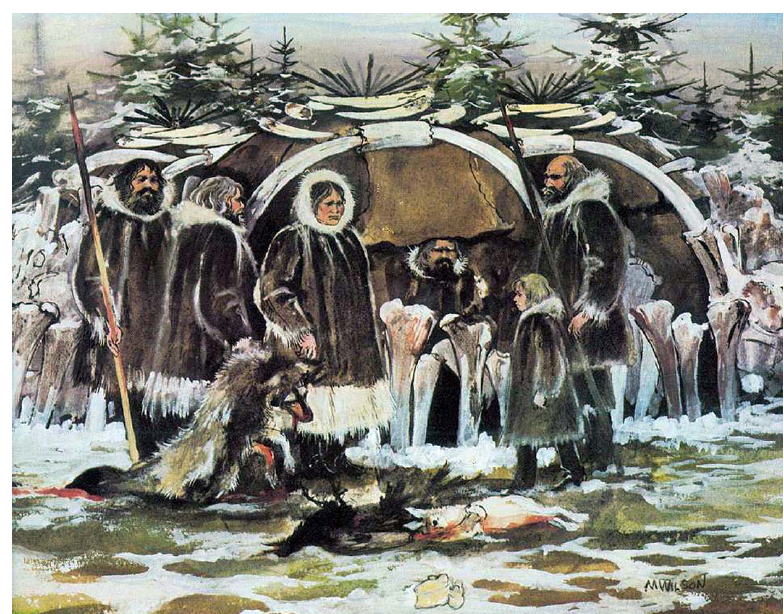
Figure 7. A family group by M. Wilson 1976 [33]. Photo: courtesy